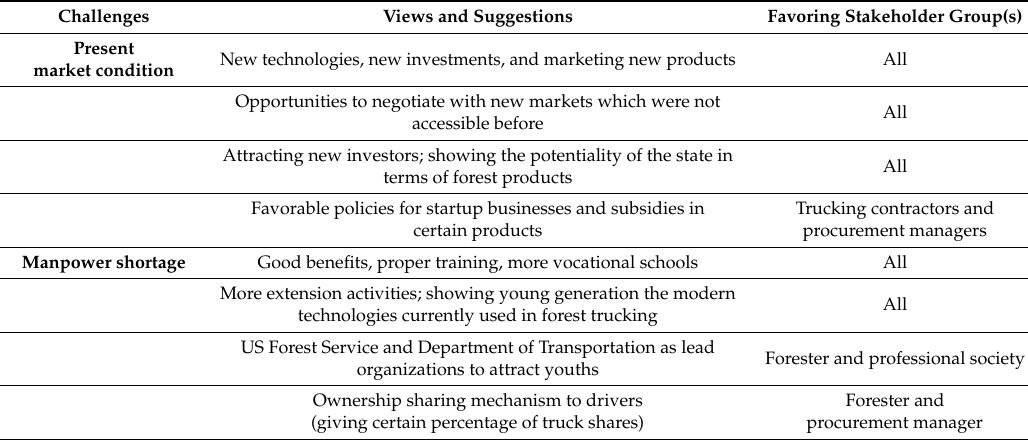
Table 4. Summary and highlights of potential mitigation measures. The measures are represented as views and suggestions of participants. The stakeholder groups favoring those strategies are also